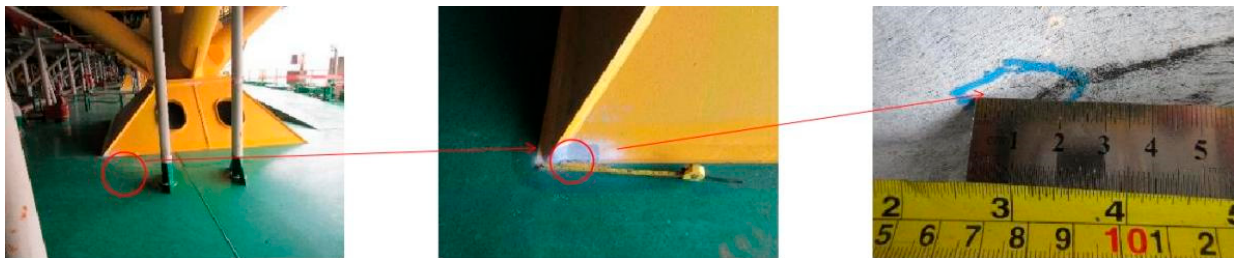
Figure 2. Diagram of the crack in the upper